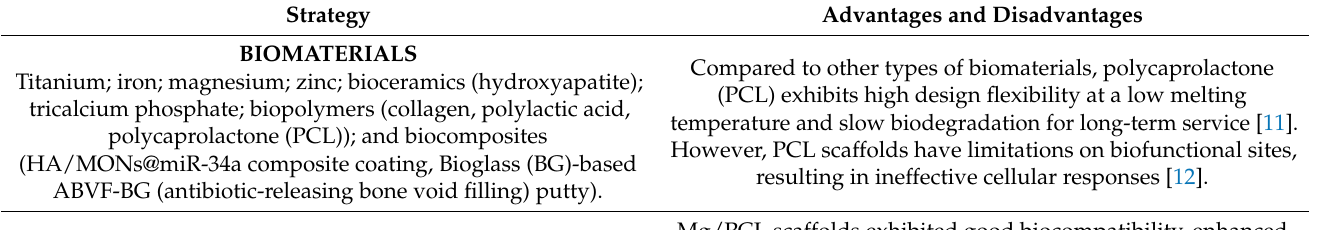
Table 1. Strategies to heal bone defects and recalcitrant nonunions using synthetic bone graft substitutes